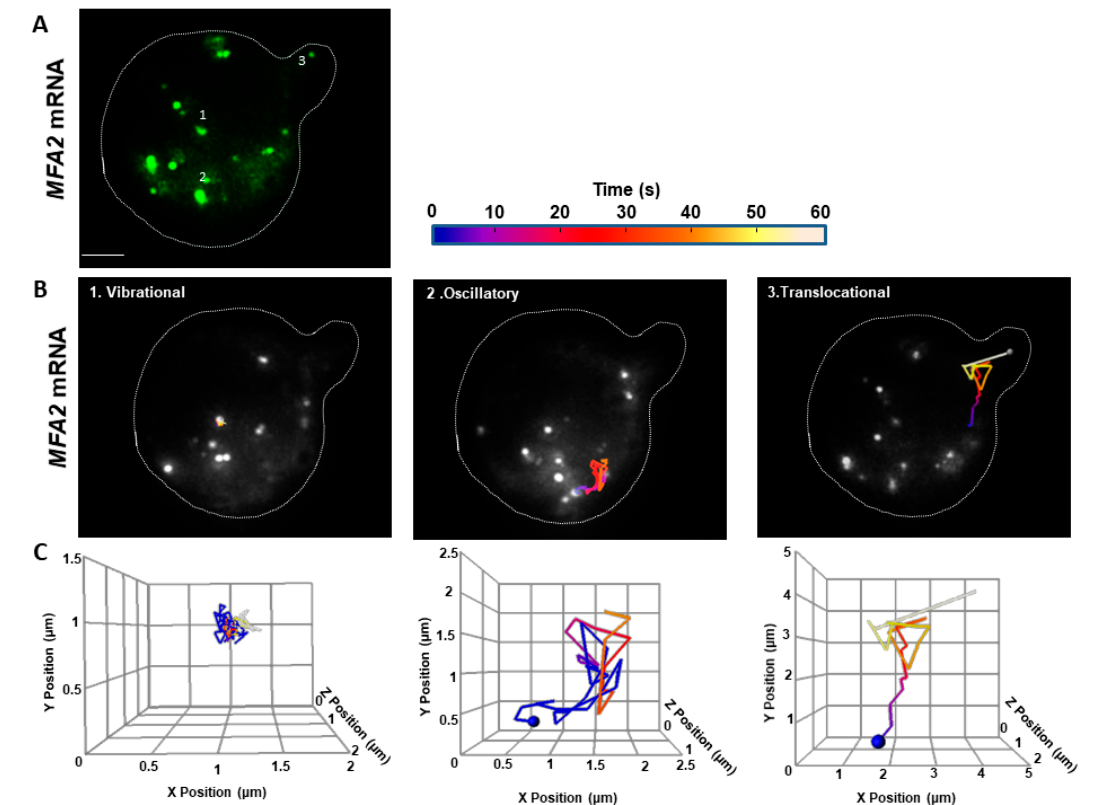
Figure 1. MFA2 granules exhibited three types of motion in 3D tracking. ( A ) U1A-GFP labeled MFA2 mRNA in a yeast cell were visualized after treatment with α -factor for 2 h. Broken line outlines the cell border with a shmoo developing on the upper right side. Numbers refer to particles tracked in ( B , C ). Scale bar = 2 µ m also applies to ( B ). ( B ) Tracks of three particles display distinct behavior movements: vibrational, oscillatory, and translocational were superimposed on images of the cell at various fixed times. Tracks were constructed from images recorded every 4 s, consolidating 6 z-stacks with a depth of 0.5 µ m for each cell. ( C ) Tracks of the MFA2 granules shown in ( B ) are shown replotted in 3D. The axes were arbitrarily resized to illustrate the movement space of the granules. Blue spheres mark the initial positions of the granules. Track duration was 60 s.